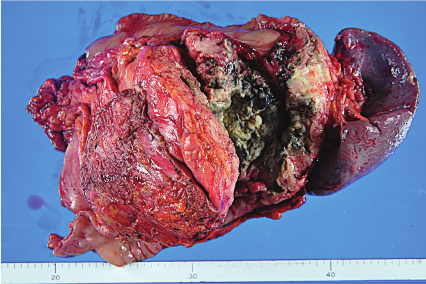
Figure 3: Macroscopic view of the resected tissue. In macroscopic view, the transverse colon is visible on the upper surface of the resected tissue, the large ulcer is visible at the front of the resected tissue, and the descending colon is visible on the lower surface of the resected tissue. The pancreas stump is not